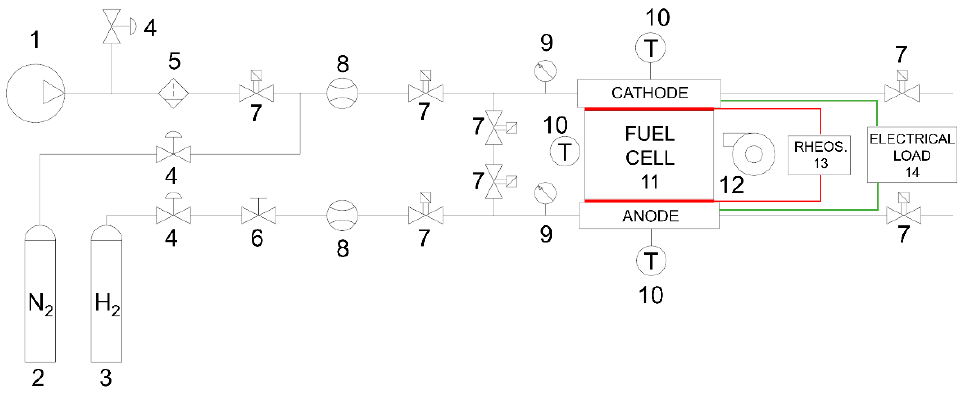
Figure 1. Test bench simplified schematic: (1) air compressor, (2) nitrogen bottle, (3) hydrogen reservoir, (4) pressure regulator valves, (5) air filter, (6) valve, (7) solenoid type valves, (8) flow meters, (9) pressure transducers, (10) thermocouples, (11) fuel cell, (12) air blower, (13) rheostat and (14) electrical load.